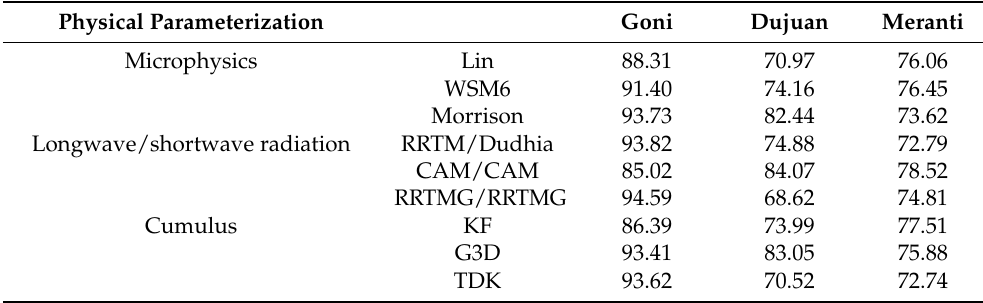
Figure 9. The temporal distributions of wind directions (degree) obtained from experiment 2 (blue dot) and buoy observations (red dot) during typhoon Meranti at the locations of four buoys. The mean skill scores for each physical scheme for the three typhoon events are shown in Table 12. From the perspective of mean skill score, experiments 27 and 13 were the best simulation experiments for typhoons Goni and Meranti, which is di ff erent from the above results and demonstrates that 27 experiments were necessary. According to the mean skill score, longwave/shortwave radiation had the greatest e ff ect on the skill score of the simulated wind directions. Table 12. Mean skill score of the single physical parameterization in the wind direction simulation. Physical